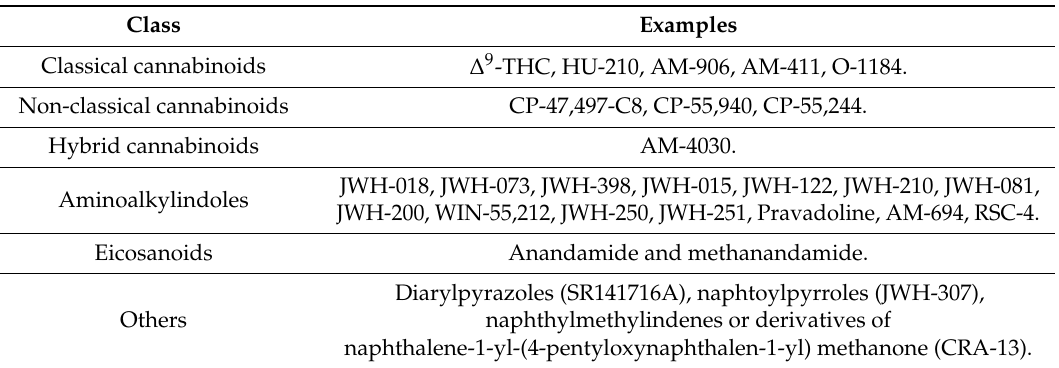
Table 1. The Classification of Cannabinoids (CBs) [32].